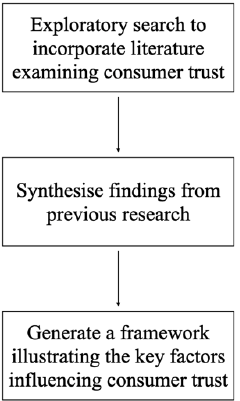
Figure 1. A flowchart illustrating the methodology steps.